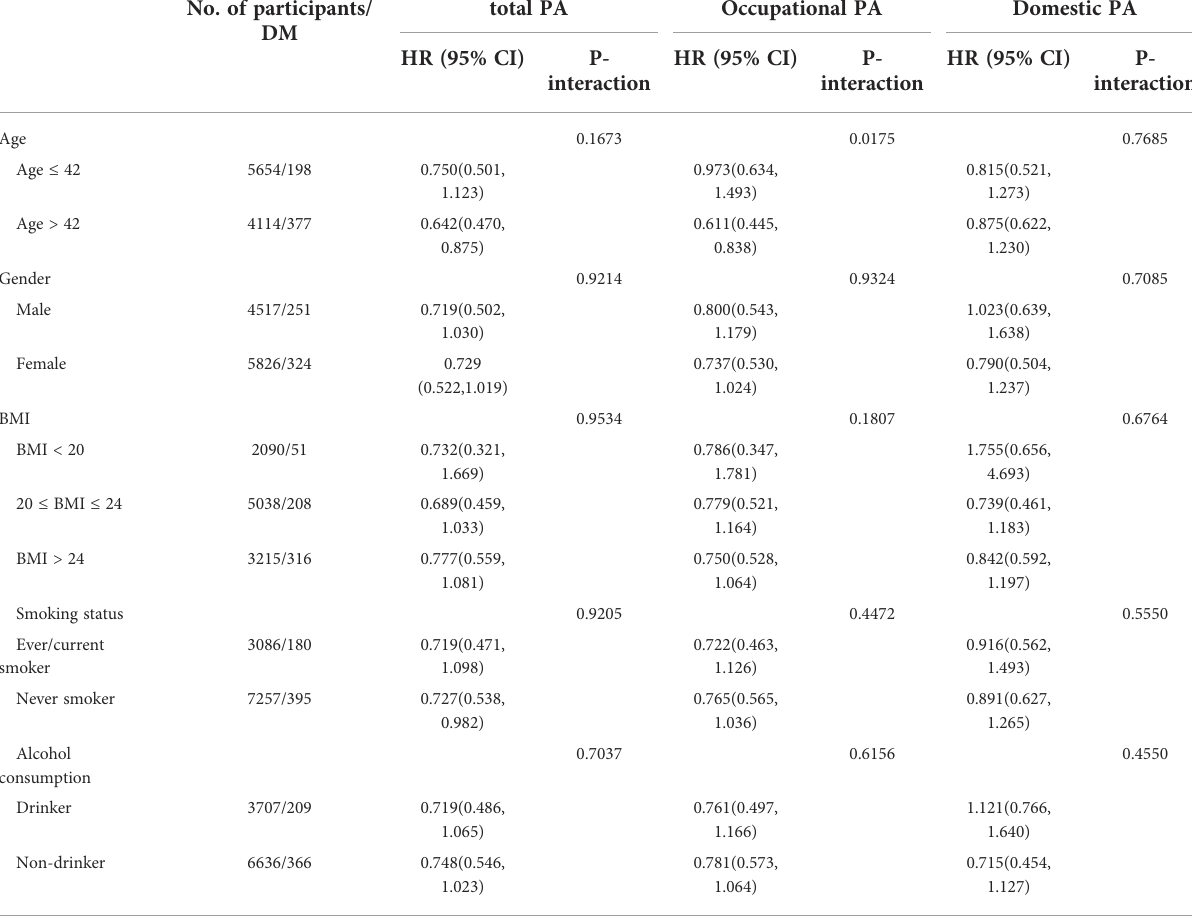
TABLE 3 HRs (95% CI) of the risk of DM according to quartiles of total PA, occupational PA, and domestic PA strati fi ed by age, sex, BMI, smoking status, and alcohol